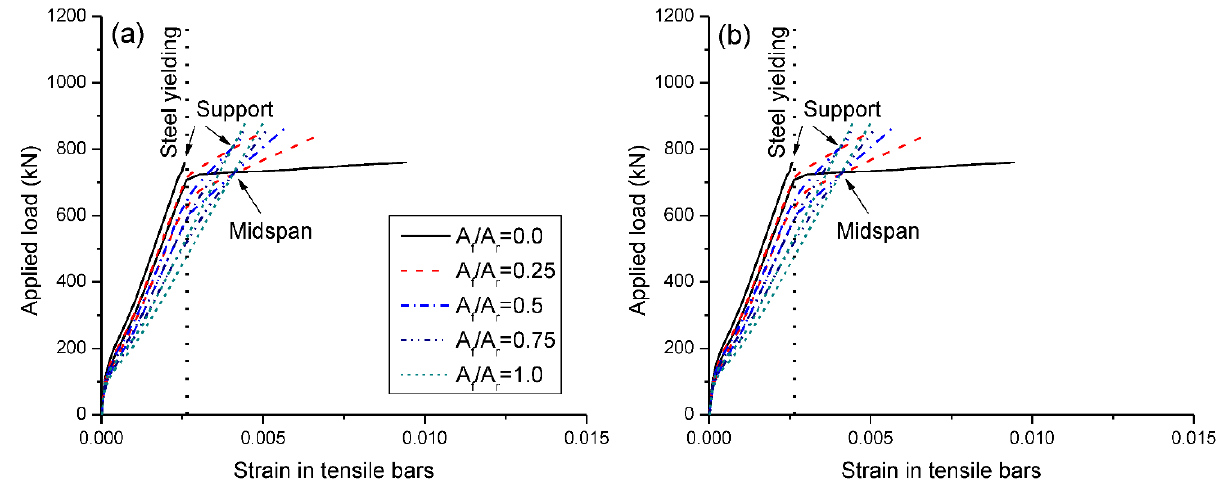
Figure 10. Load versus bar strain: ( a ) symmetrical loading; ( b ) unsymmetrical loading.